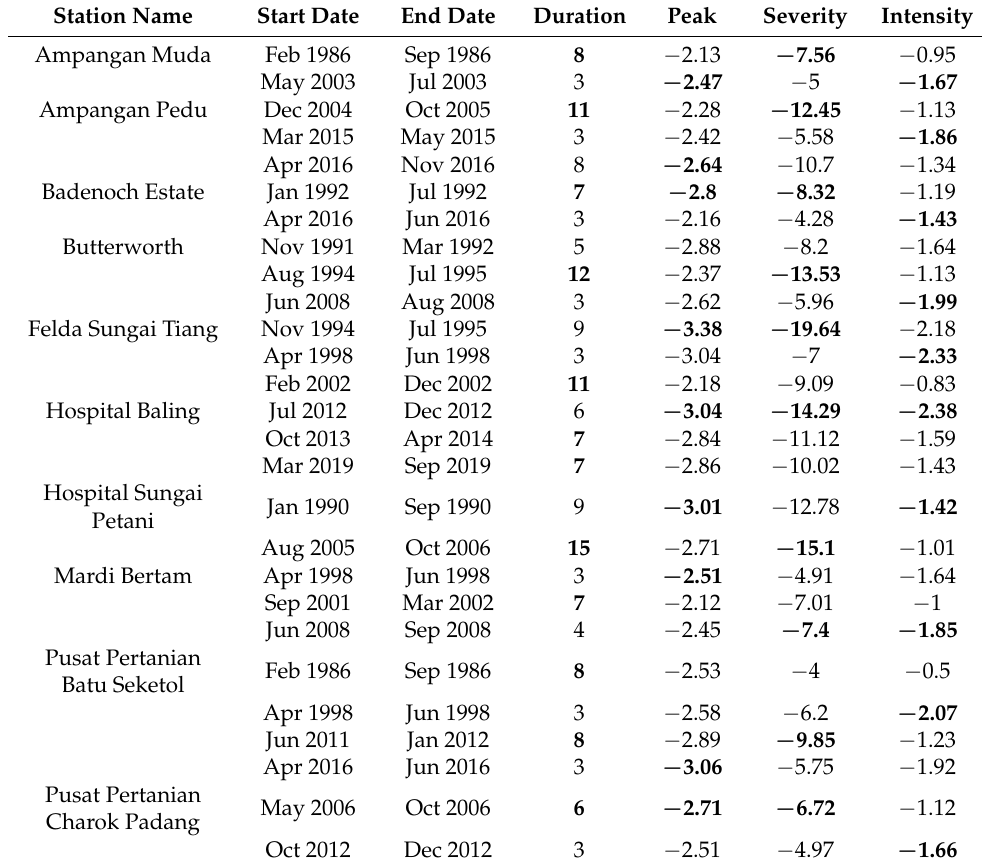
Table 5. Summary of extreme drought (< − 2) occurrences with the maximum drought characteristics (1985–2019); bold values indicate the maximum drought